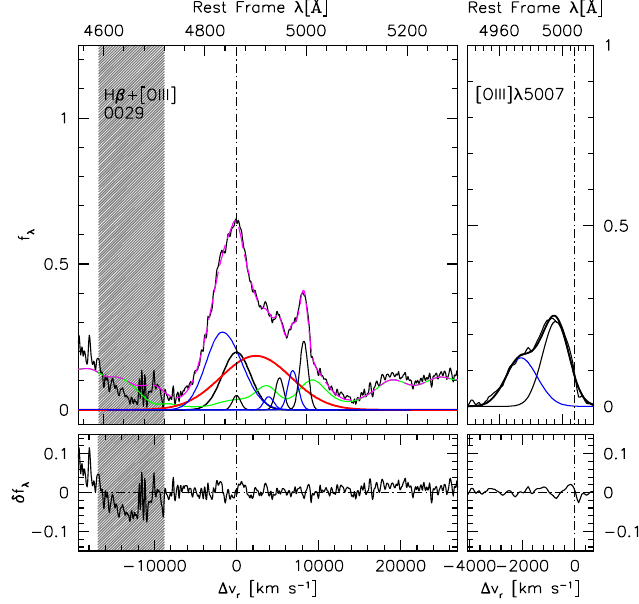
Figure 2. Analysis of the H β + [O III ] λλ 4959,5007 region for two high-luminosity, high- z quasars be- longing to the B1 spectral type. The top one, HE0001-234, shows no appreciable evidence of blueshift, while the bottom one (HB89) 0029+073 requires a stronger blue shifted excess for [O III ] λλ 4959,5007 and an even stronger and broader one to fit H β . Color coding of the components is the same as in the previous Figure. The shaded area identifies a spectral region affected by atmospheric